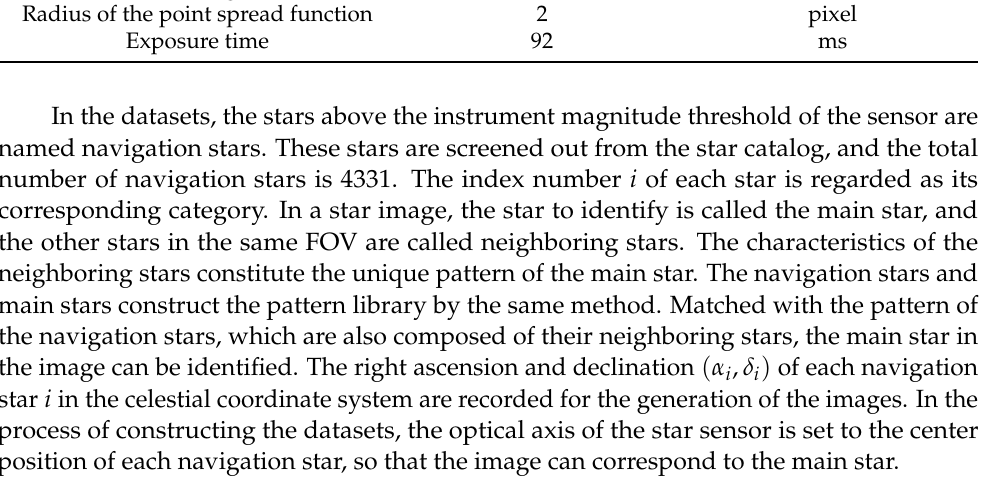
Table 1. Simulation parameters of the optical system. Item Quantity Unit Image plane dimension 1024 × 1024 pixel Pixel size 0.012 × 0.012 mm Instrument magnitude threshold 6 Mv FOV 12 × 12 Focal length 58.5 Radius of the point spread function Exposure